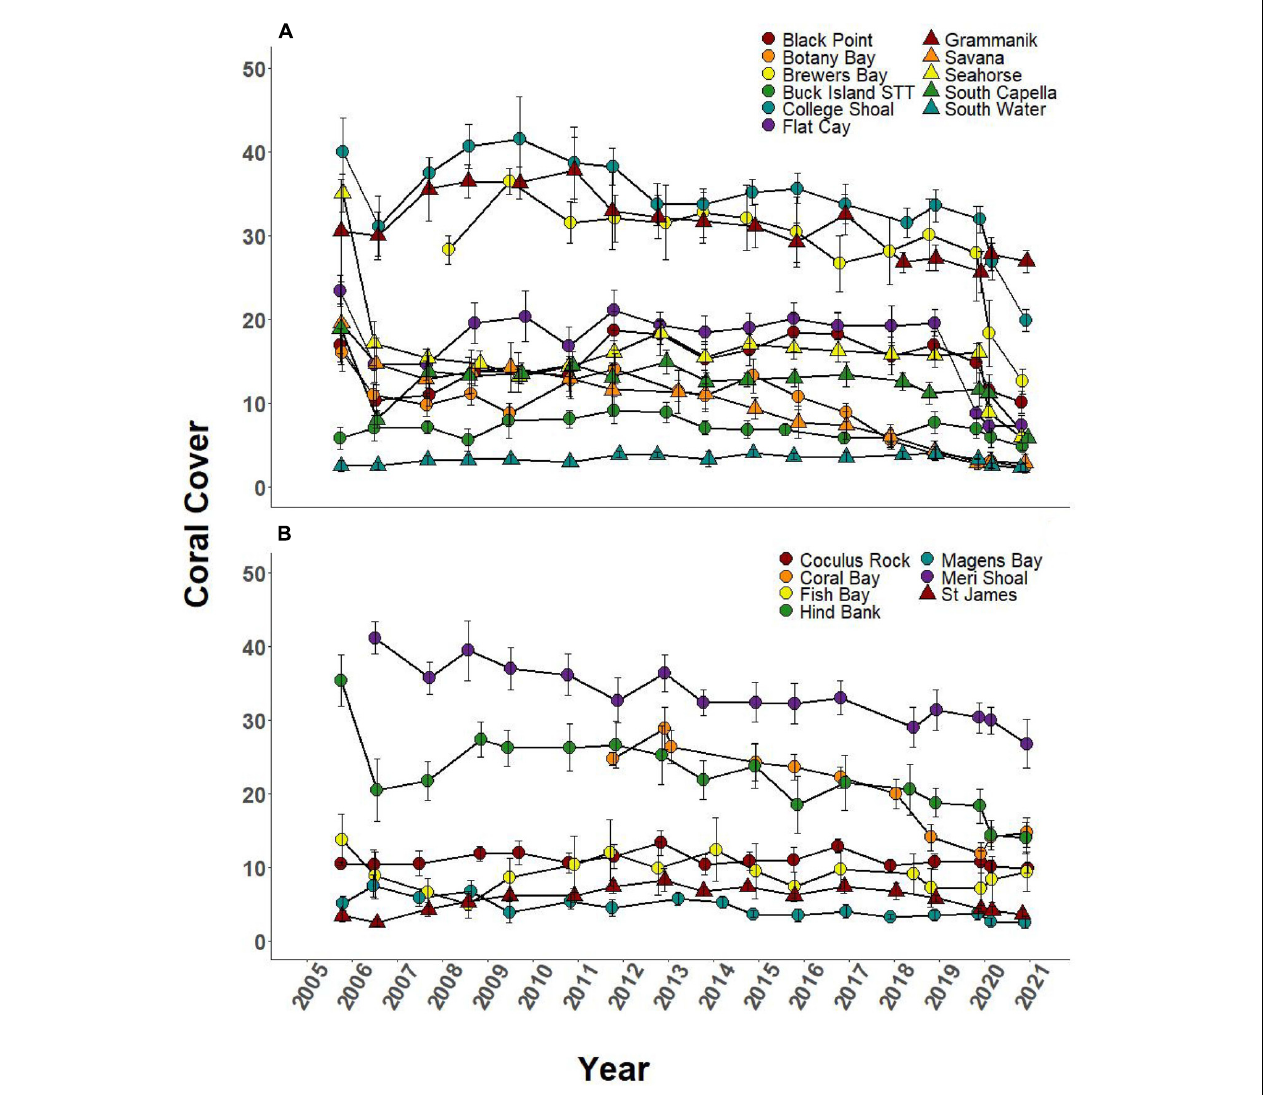
FIGURE 6 | Temporal series of % coral cover ( ± SEM) at northern USVI TCRMP locations from 2001 to 2019. (A) Locations with SCTLD present; (B) Locations with no SCTLD present as of December